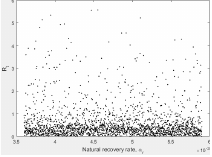
Figure 7. The scatter plot is having relatively poor pattern than Figures 5–6 indicating that the correlation between R t and β is week implying that R t is poorly sensitive to β .